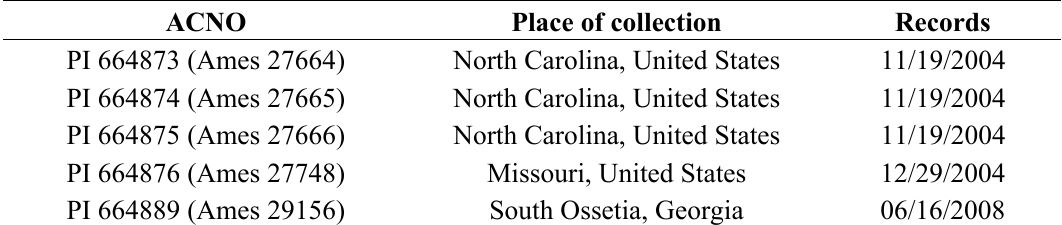
Table 1. List of Prunella vulgaris accessions used in this study, their geographical origin and date of collection. All accessions were grown at the USDA Plant Introduction Station, Ames,